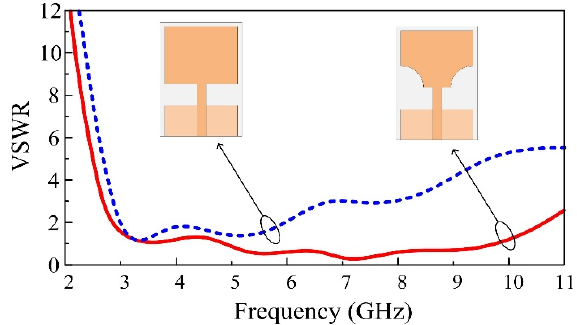
Figure 3. Comparison of a conventional rectangular monopole and a truncated corner UWB an ‐ tenna.